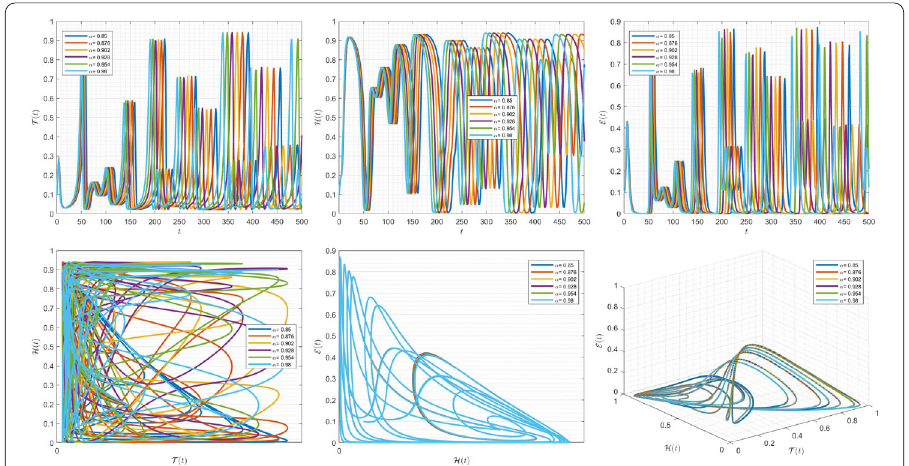
Figure 4 Simulations for solving (29) using (42) along with ( T (0), H (0), E (0)) =